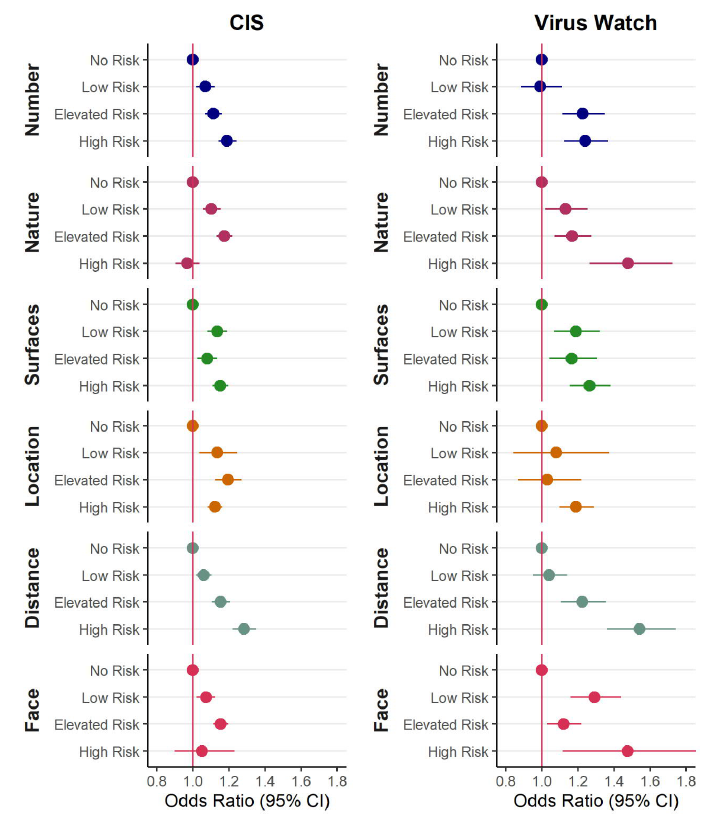
Figure 1. Odds ratios by level of exposure for 6 domains of the job exposure matrix (compared to the no risk group) from [Virus Watch (N=16 801) an d COVID-19 Infection survey (CIS) (N=244 470)] participa nts in work and aged 20-64. Models adjusted for age quintile, sex, ethnicity, index of multiple deprivation (IMD) / health conditions, region, household size, urban versus rural area, and presence of health conditions. Domains relating to insecurity and migrant workers not displayed here due to imprecision. See table 1 for explanation of abbreviations. [CI=confidence